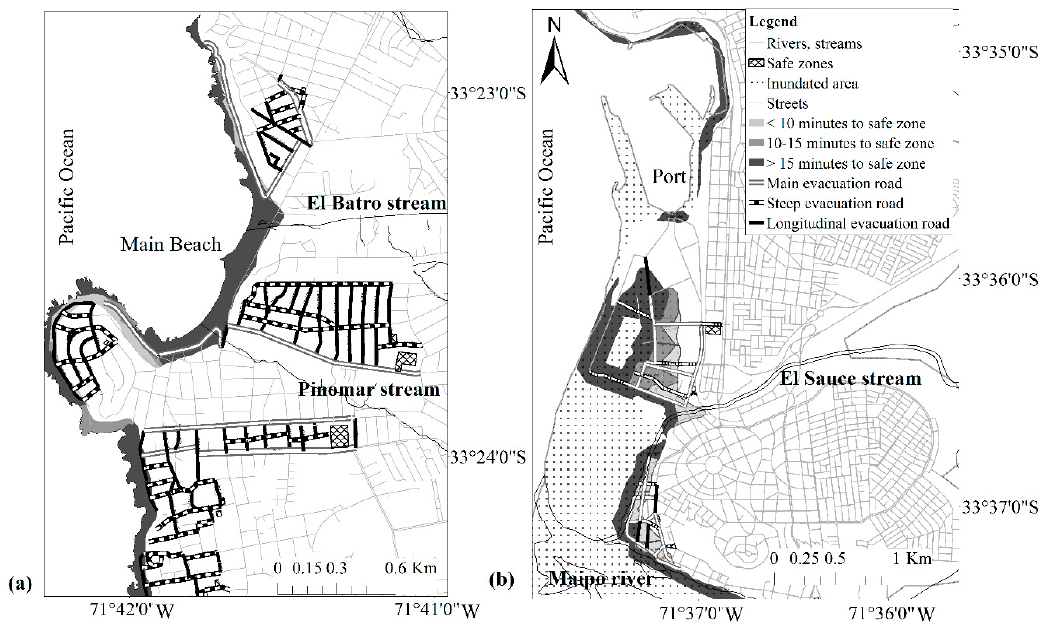
Figure 9. Tsunami evacuation plan at ( a ) El Quisco and ( b ) San Antonio.